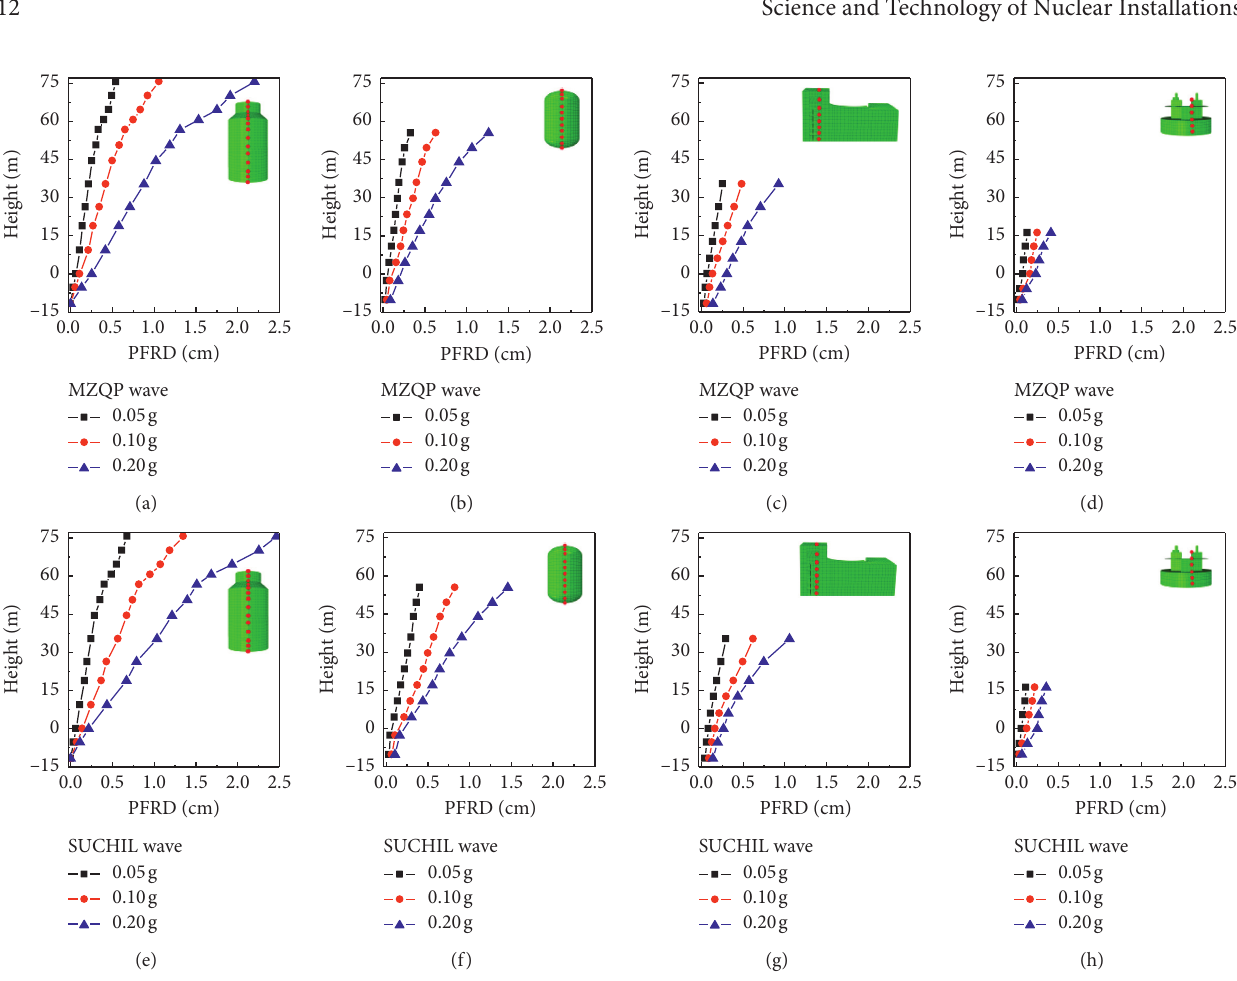
Figure 13: Relationship between the PFRD and the height of the nuclear island